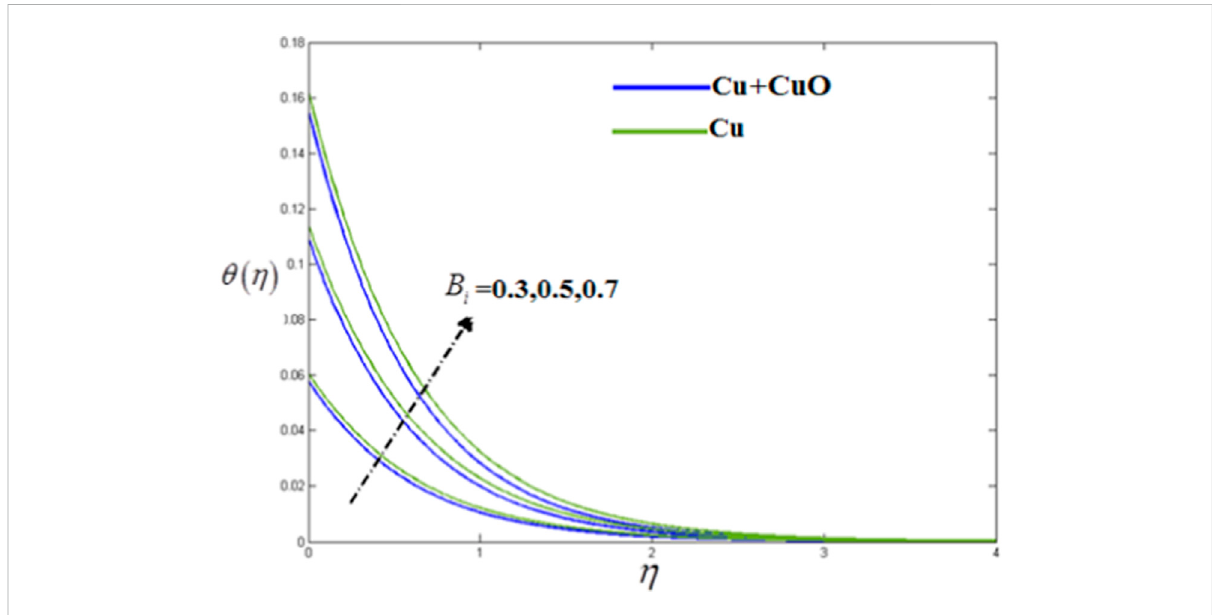
FIGURE 8 B i versus θ ( η ) . When, k (cid:2) 0 . 2 , Λ (cid:2) 0 . 4 , ϕ 1 , ϕ 2 (cid:2) 0 . 02 , Rd (cid:2) 0 . 3 , Gr (cid:2) 0 . 1 , Pr (cid:2) 6 . 2.